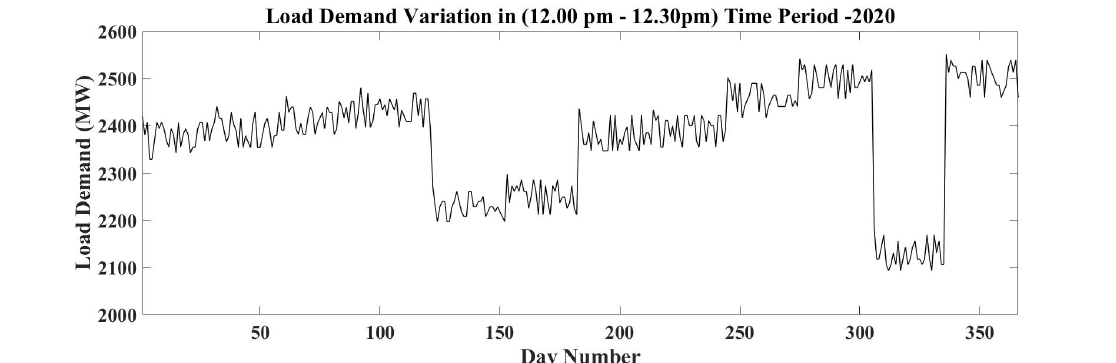
Figure 5 : Load Demand Variation in 2020 .